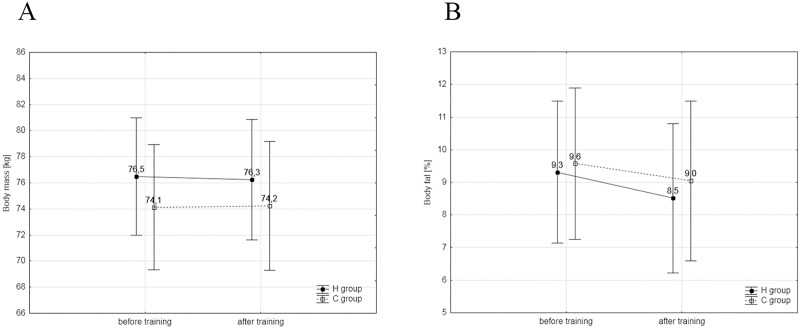
A, B. Body mass and composition.(A)Values of body mass and in the experimental (H, n = 8) and control groups (C, n = 7). (B)Values of body fat in the H and C groups.